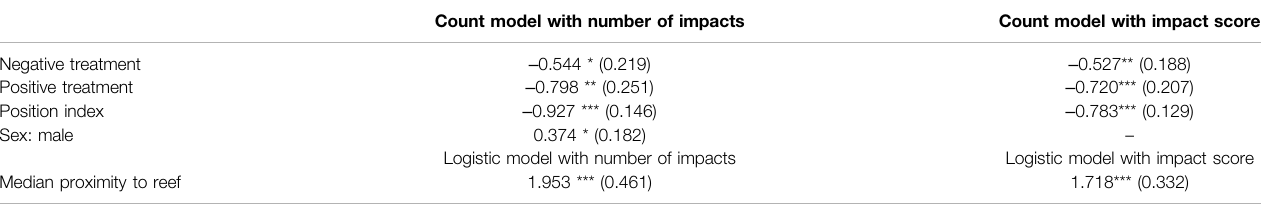
TABLE 7 | Regression results for number of impacts (ZIP) and impact score (ZINB).